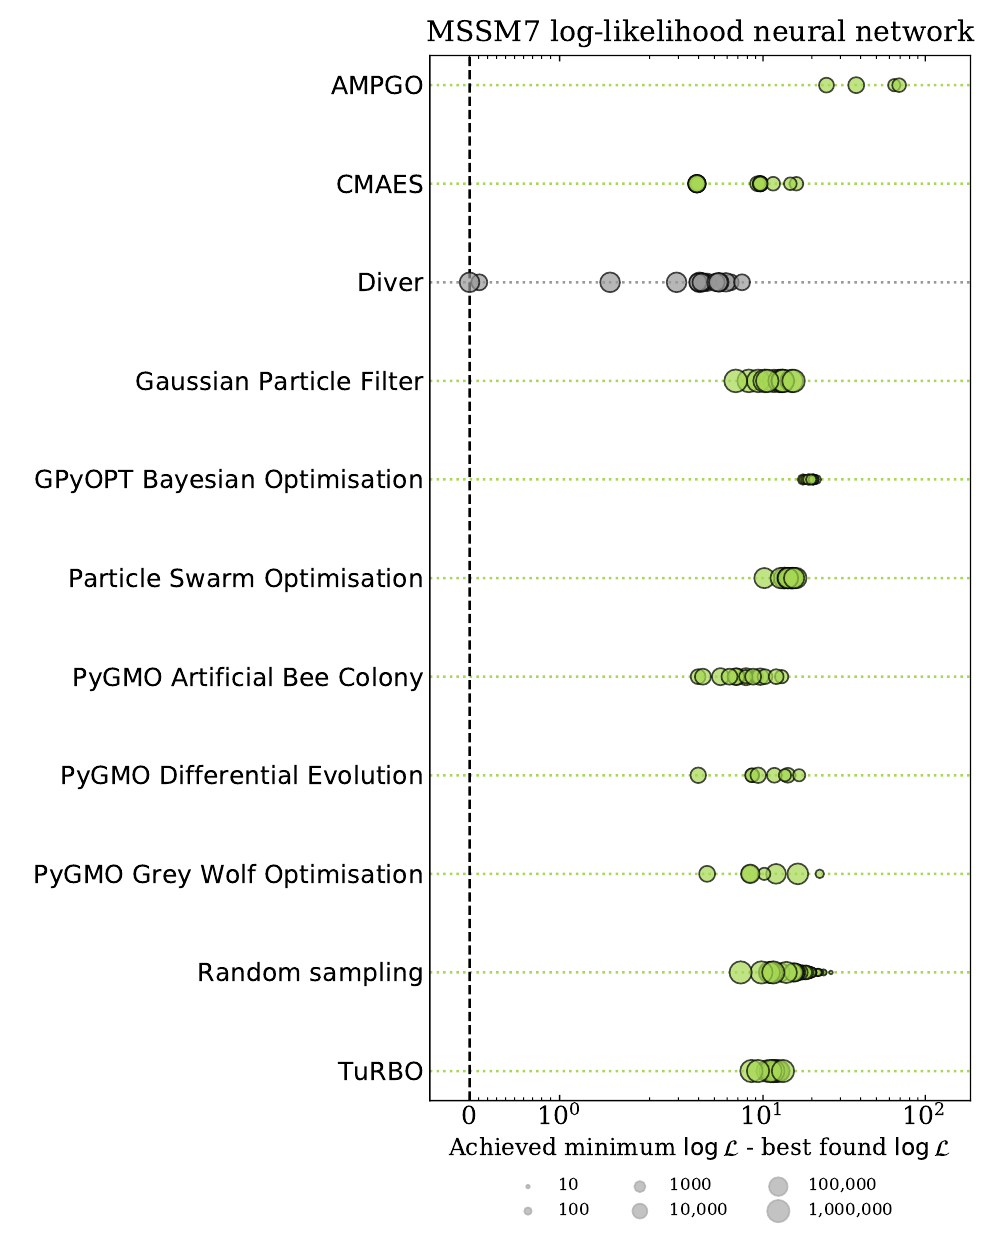
Figure 8. Results from different optimisation algorithms on the neural network approximation of the MSSM7 log-likelihood described in section 3.2. The results are shown as semi-opaque circles, of which the area increases logarithmically with the number of function evaluations needed to obtain that specific result. The horizontal axis shows the difference between the log-likelihood at the found minimum and the deepest minimum found by any algorithm for any settings. To emphasise the possible bias in the test function towards Diver , the results for that algorithm are coloured